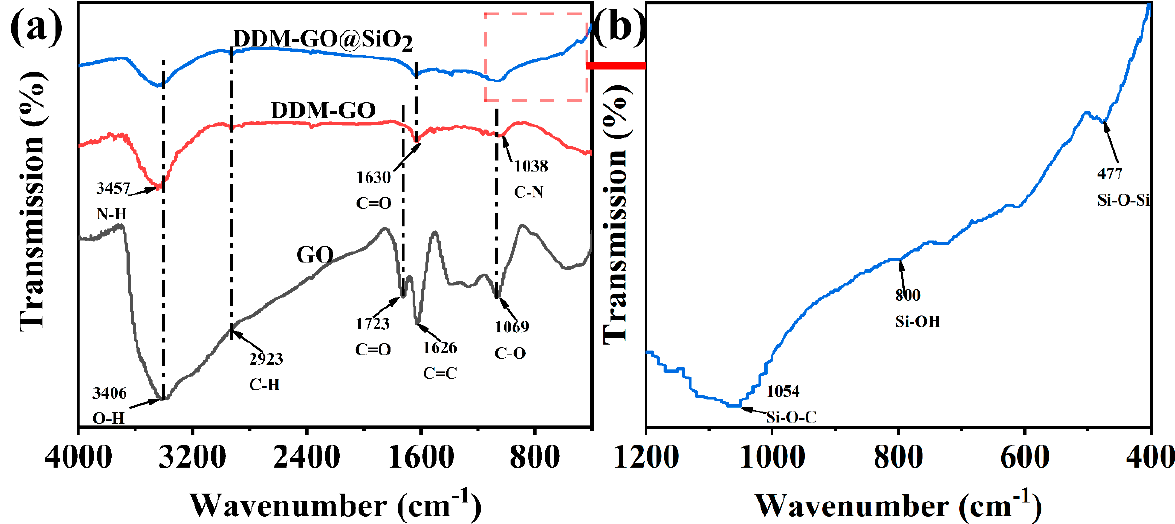
Figure 1. ( a ) FT − IR spectra of GO, DDM − GO, DDM − GO@SiO 2 , ( b ) partial enlarged view of DDM − GO@SiO 2 .